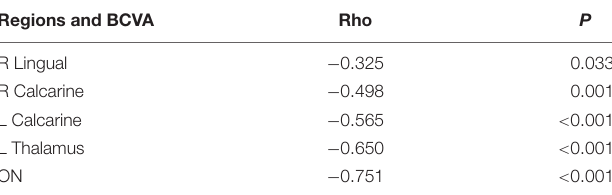
TABLE 3 | Correlation between frequency of ON attack and FC values. Regions and BCVA Rho P R Lingual − 0.325